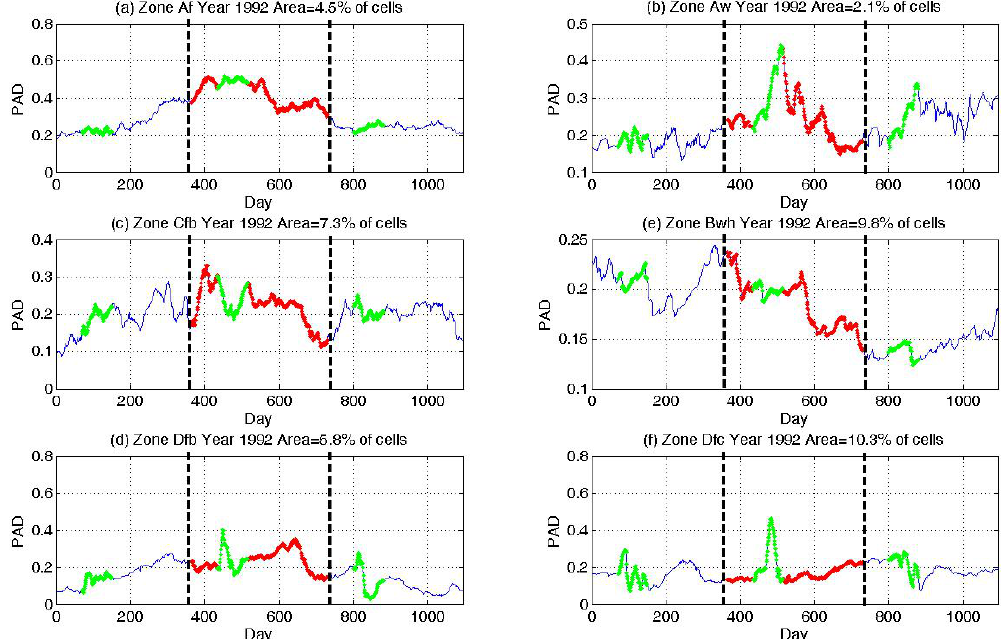
Fig. 8. Development of the PDA in six selected major K¨oppen-Geiger hydro-climatic regions over the years 1991 to 1993 (red line is